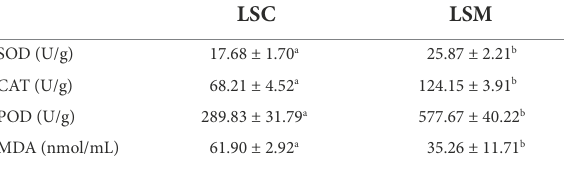
Values marked with superscripts with different letters are significantly different (P <